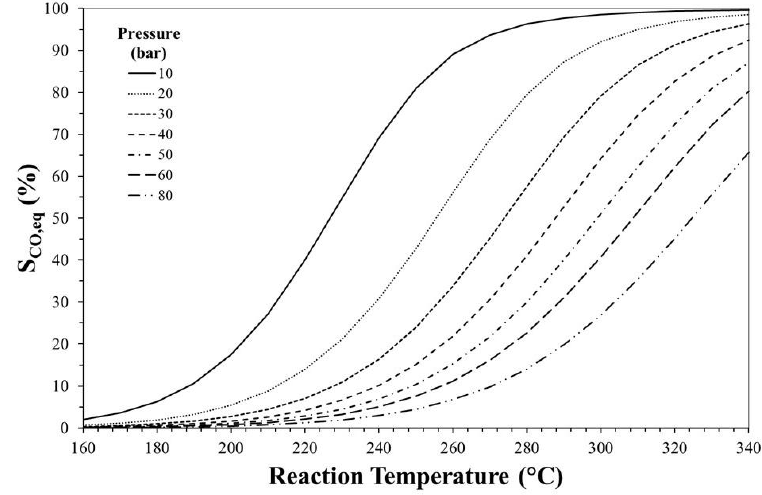
Figure 4. Effect of reaction temperature and pressure on CO equilibrium selectivity. Initial H 2 /CO 2 molar ratio equals to 3.